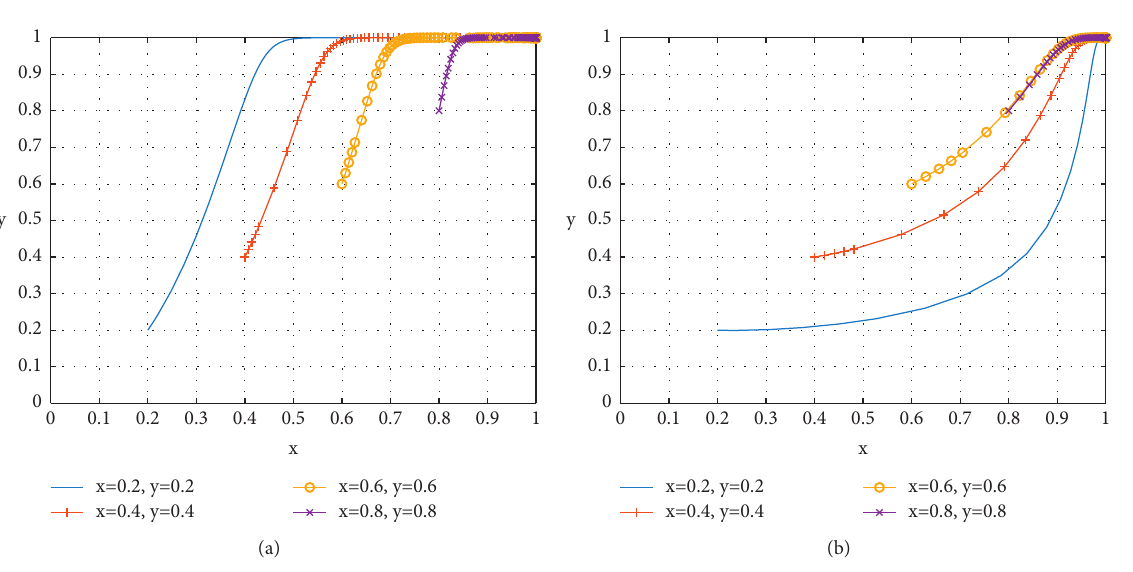
Figure 1: Simulation results of Case 1.